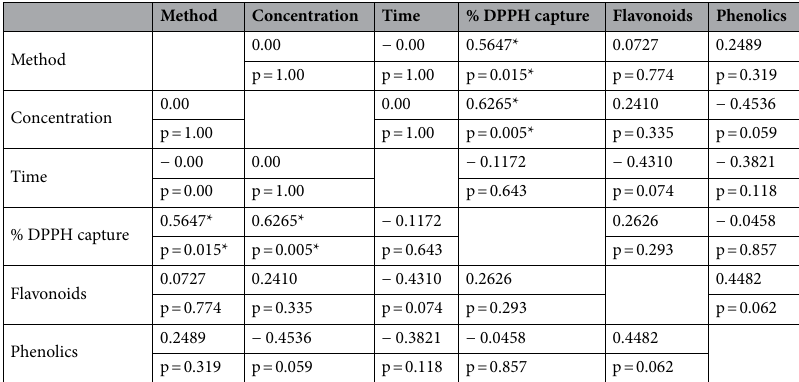
Table 5. Pearson correlation for aqueous solvent. *Results statistically significant.